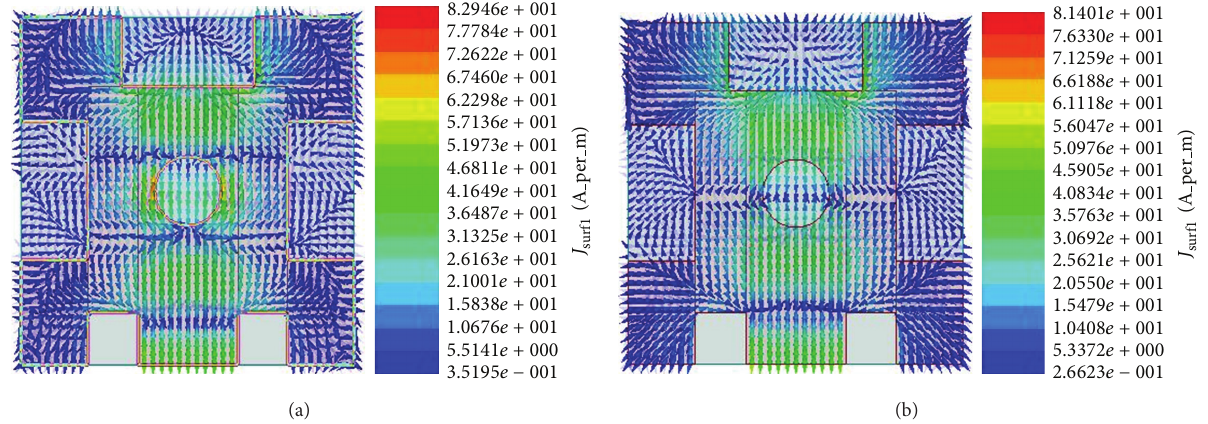
Figure 16: Current distribution of the proposed antenna at (a) 15.56 GHz and (b) 20.41 GHz.